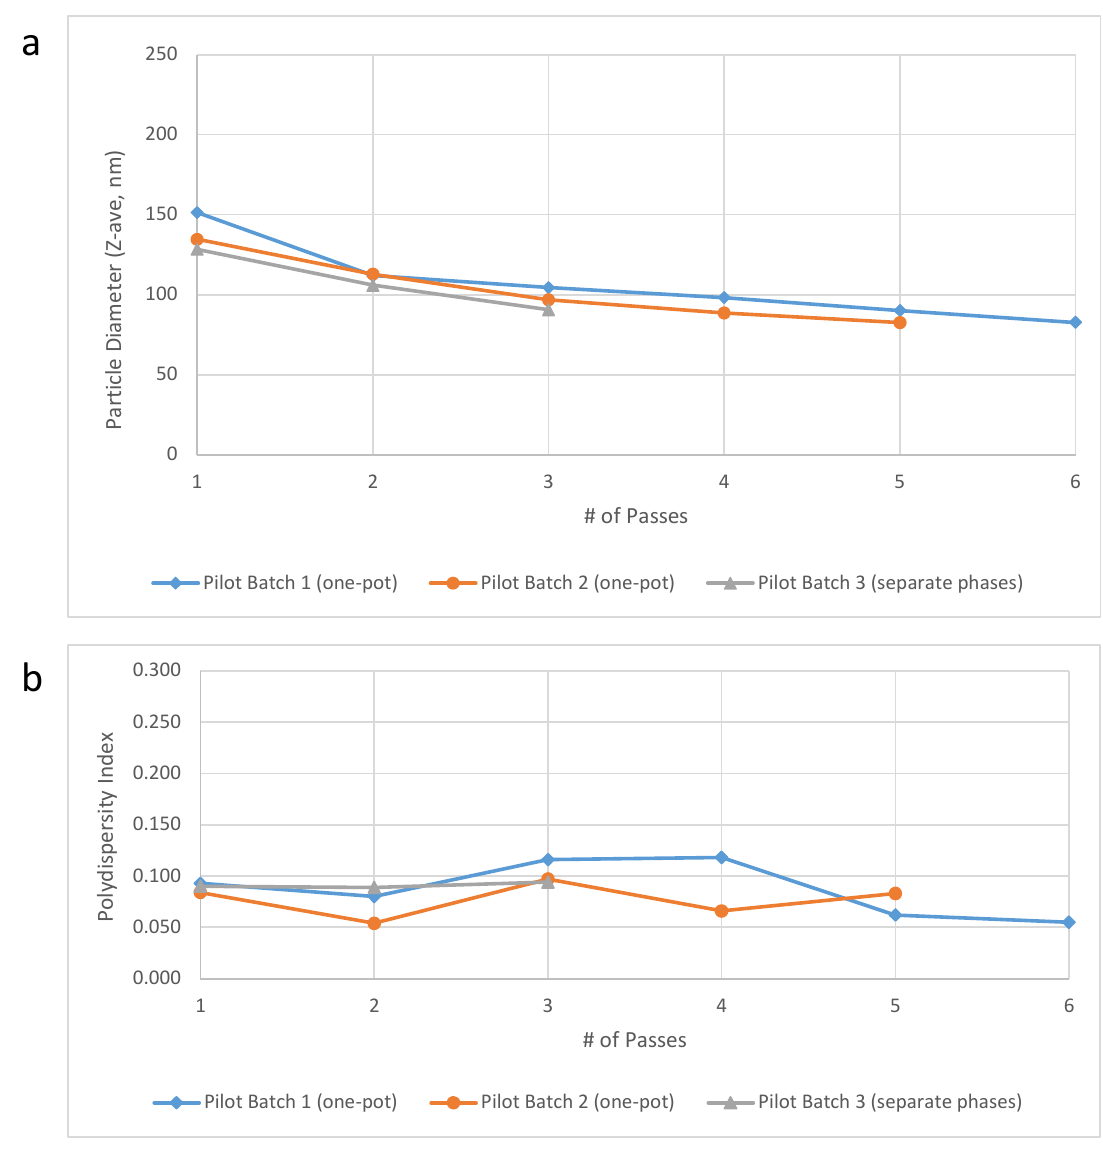
Figure 3. Droplet diameter ( a ) and polydispersity index ( b ) as a function of number of passes through the Microfluidizer processor in 30% v/v oil-in-water emulsion batches produced at the pilot scale (10 L) using the one-pot approach or the traditional separate phases approach as indicated.